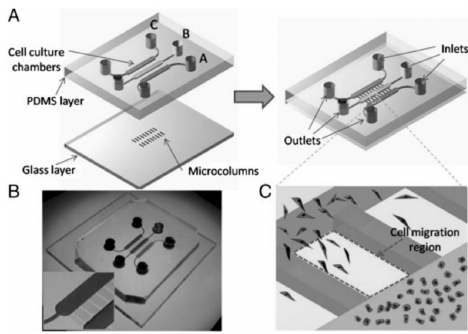
Figure 11. Interaction of hepatocarcinoma and fibroblast cells in a microfluidic device: ( A ) layout of cell co-culture chambers with parallel regions to capture migrating cells; ( B ) photograph of the microfluidic device; ( C ) magnified image of the cell migration through parallel regions [120].